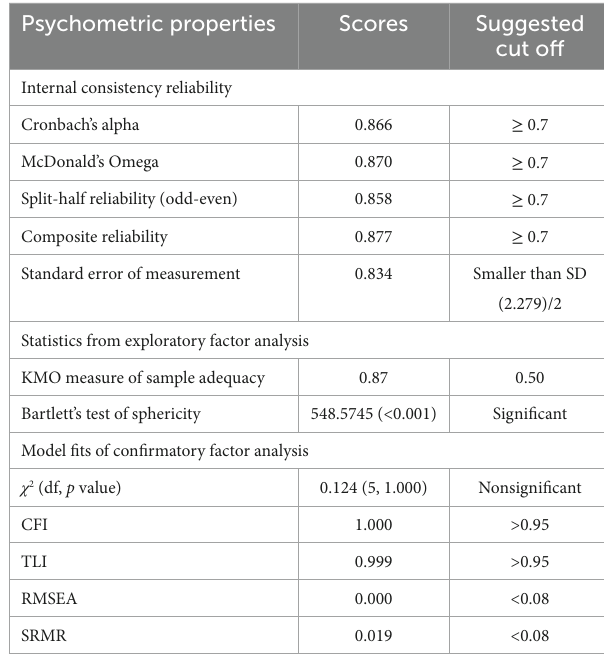
TABLE 3 Scale-level psychometric properties of the PGS for healthcare